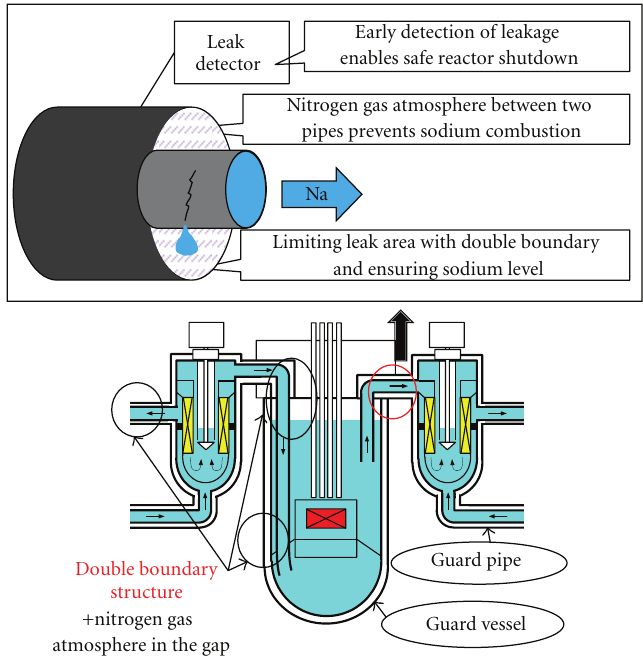
Figure 3: Schematic diagram of the double-wall